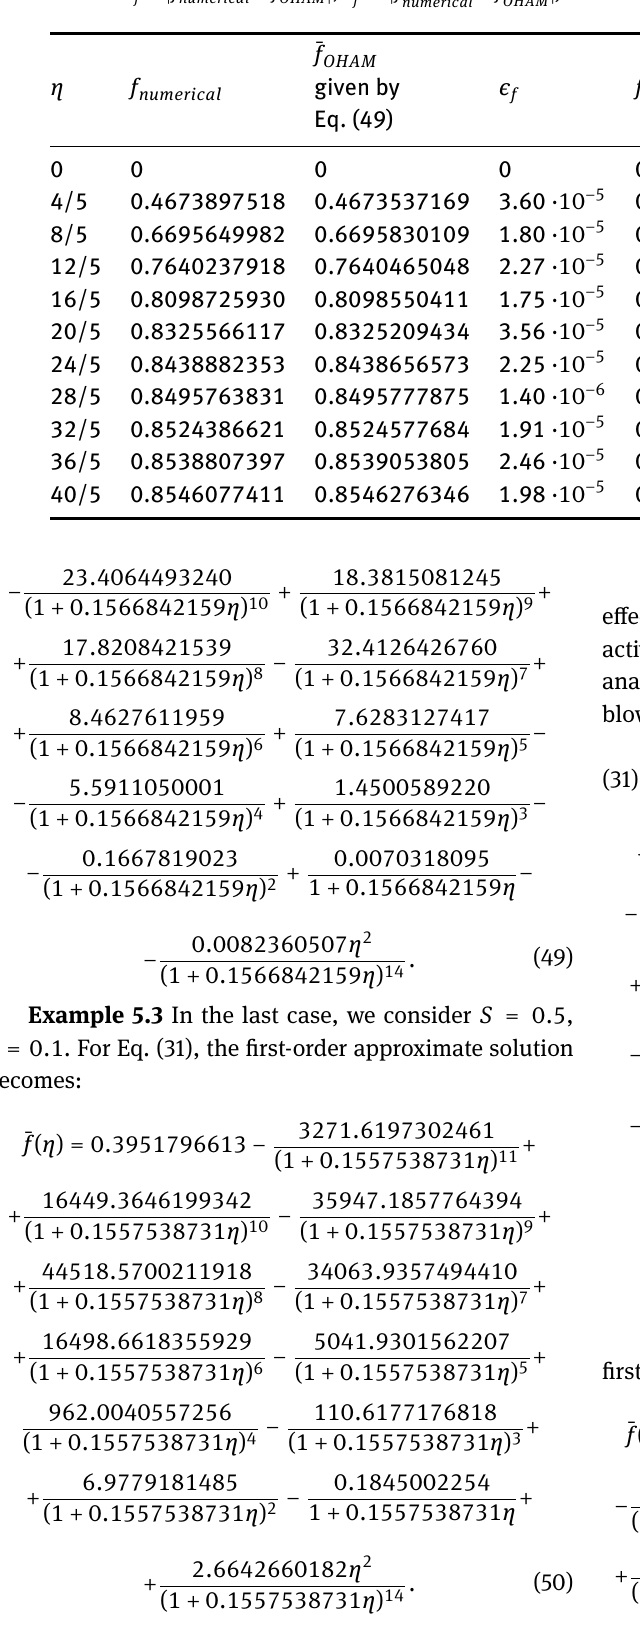
Table 3: Comparison between OHAM results ( ¯ f , ¯ f ′ ) given by Eq. (49) and numerical results, for S = 0 , λ =